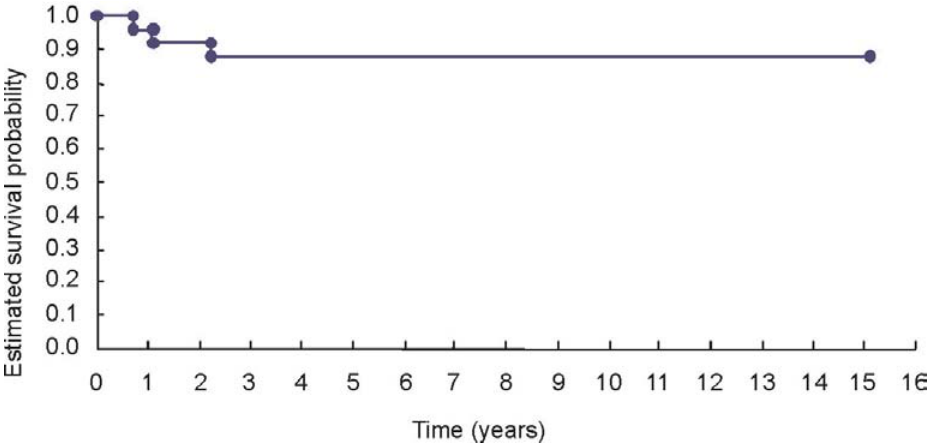
Figure 3 - Curve depicting overall survival (years) for the 25 patients with liposarcoma of the extremities cal grade ( P = 0.003) were also considered adverse